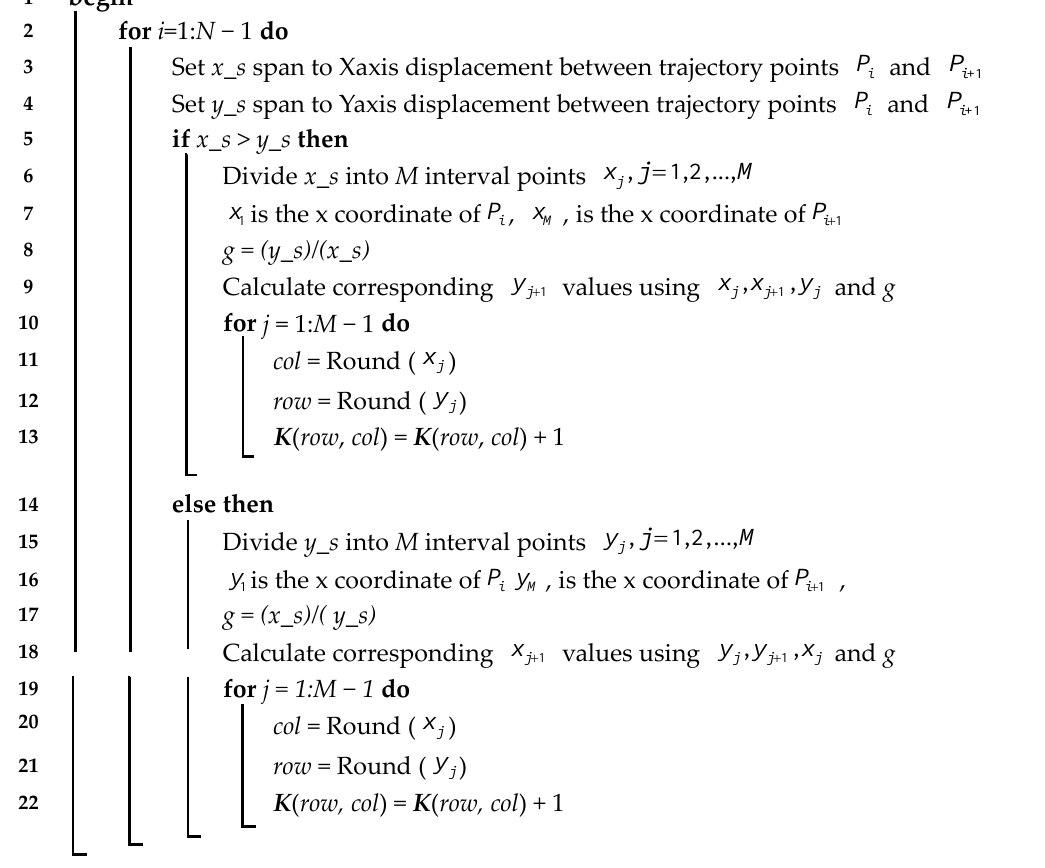
Algorithm 1: linear interpolation between adjacent two trajectory points